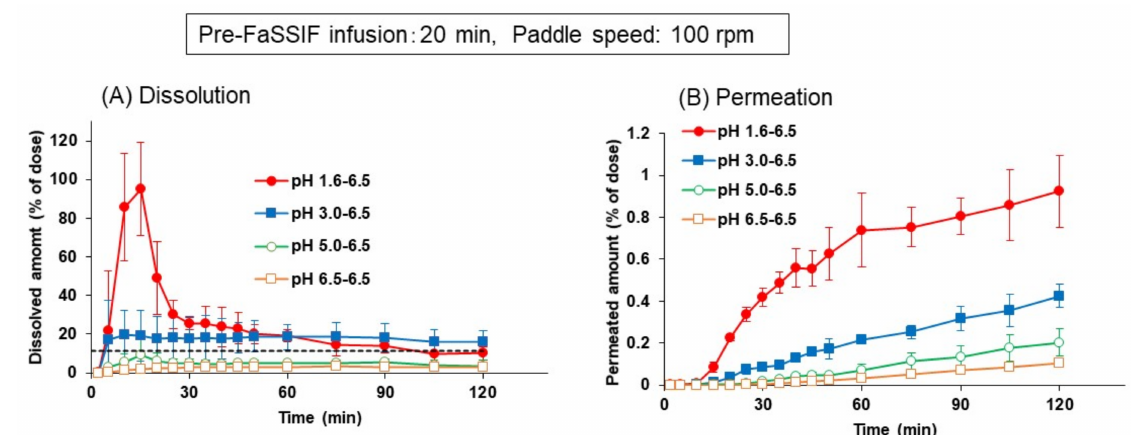
Figure 7. Effect of initial FaSSGF pH on the dissolution ( A ) and permeation ( B ) time profiles of dipyridamole from Persantin ® tablets 25 mg in the BE checker. Each data point represents mean ± S.D. ( n =